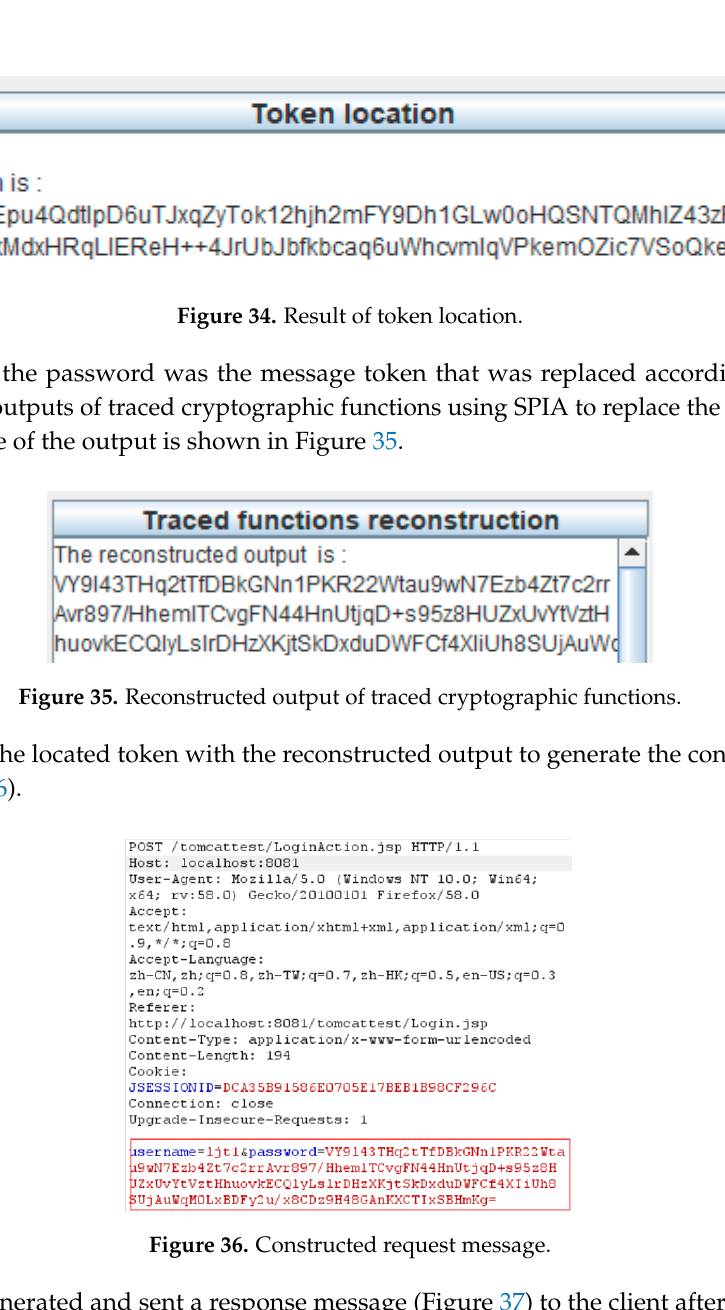
Figure 33. Response message.